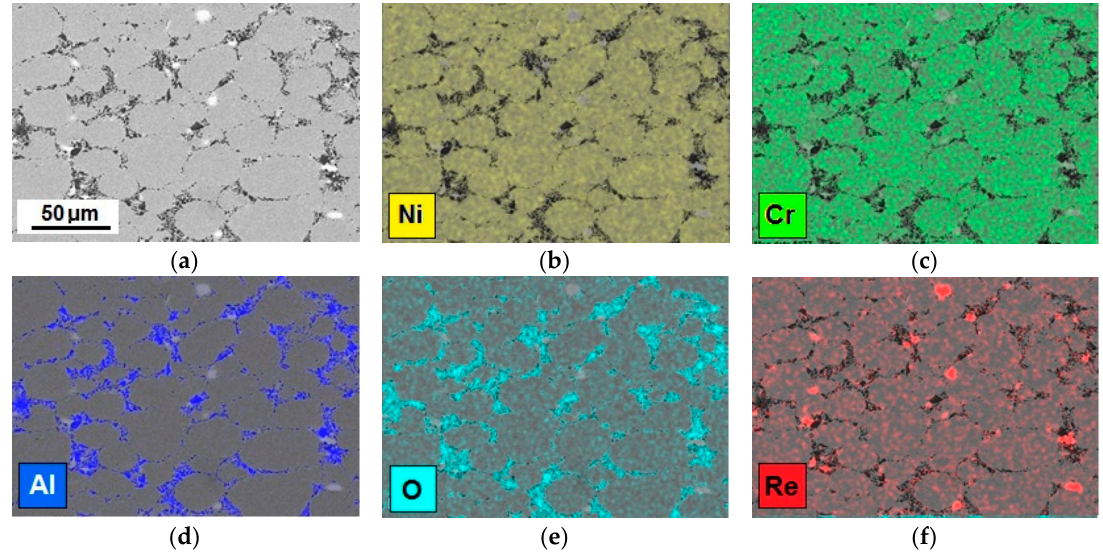
Figure 3. SEM micrograph ( a ) and EDX analysis ( b – f ) of the surface distribution of the elements